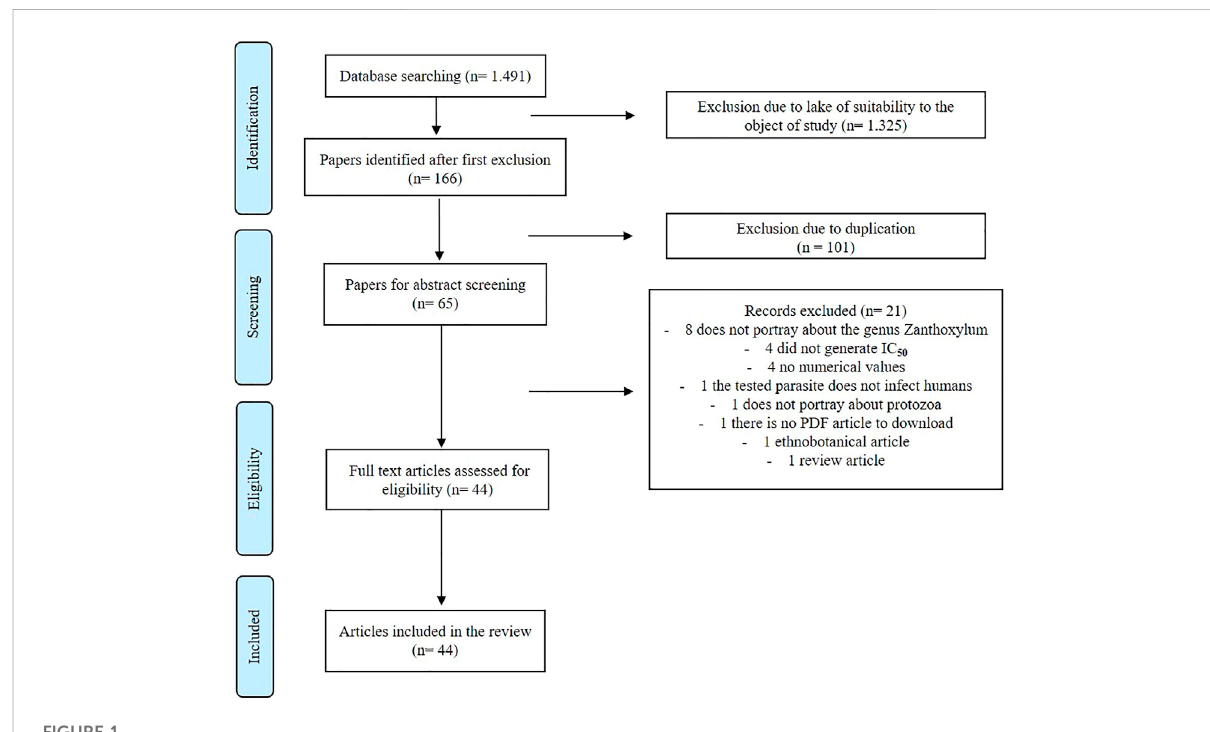
FIGURE 1 Article selection process.